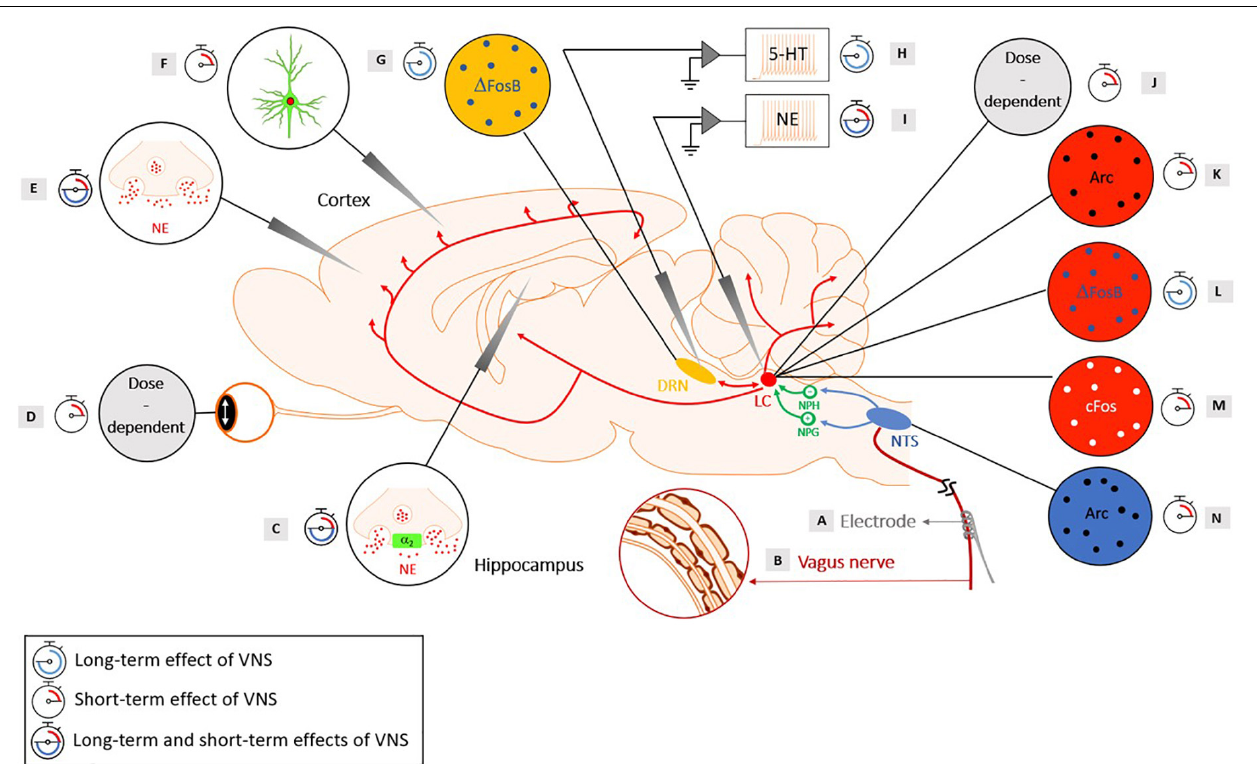
FIGURE 1 | Evidence of the activation of the noradrenergic system in rats with short-term and long-term cervical VNS, with the neuroanatomy of the brainstem nuclei involved in the mechanisms of action of VNS. Yellow: Dorsal Raphe Nucleus (DRN), red: Locus Coeruleus (LC), green: Nucleus Prepositus Hypoglossi (NPH), an inhibitory input to the LC and the Nucleus Paragigantocellularis (NPG), an excitatory input to the LC, blue: Nucleus Tractus Solitarius (NTS). (A) A helicoidal electrode is wrapped around the vagus nerve and stimulates the nerve. (B) The vagus nerve is composed of three types of fibers: (A) (large-diameter myelinated), (B) (small-diameter myelinated) and (C) (unmyelinated) fibers that have different electrical conductances. (C) An intensity-dependent increase in NE concentration following VNS was observed in the hippocampus of healthy rats for a range of intensities of 0.5–1 mA (20 Hz, 500 µ s pulse width, and 30 s duration) (Roosevelt et al., 2006). Another study observed an increased concentration of extracellular NE in the hippocampus following VNS administration (1 mA, 30 Hz, 250 µ s pulse width, 7 s ON, and 18 s OFF), with an increase of at least 70% preventing the development of pilocarpine-induced limbic seizures (Raedt et al., 2011). Blocking the α 2 -adrenoreceptor in the hippocampus of rats that were responders to VNS reversed the seizure-suppressing effects (Raedt et al., 2011). An increased activation of post-synaptic α 2 -adrenoreceptors located in a subfield of the Cornu Ammonis (CA3) of the hippocampus was observed after long-term VNS (2 weeks, 0.25 mA, 20 Hz, and 500 µ s pulse width) (Manta et al., 2013). A study showed that VNS (1 mA, 20 Hz, and 500 µ s pulse width) produced a persistent enhanced synaptic transmission between the perforant path and the CA3 region that was abolished when the LC was lesioned and when a β -adrenergic receptor antagonist was injected in the lateral ventricle (Shen et al., 2012). (D) During stimulation, a sigmoid-like relationship was found between the pupil dilation and the charge per pulse (Mridha et al., 2021). An increased pupil diameter was observed with an increasing current intensity and duration in a dose-dependent manner (Collins et al., 2021). (E) A significant increased NE was reached in the cortex following VNS with an intensity of 1 mA (20 Hz, 500 µ s pulse width, and 30 s duration) (Roosevelt et al., 2006). Another study observed an increased level of extracellular NE in the prefrontal cortex after long-term VNS (2 weeks, 0.25 mA, 20 Hz, and 500 µ s pulse width) (Manta et al., 2013). (F) A study using GCaMP6s imaging in Thy1-GCaMP6s mice revealed an increased fluorescence in NE axons within the dorsal cerebral cortex during VNS, with larger and longer lasting effects for higher intensities and longer pulse width stimulations (Collins et al., 2021). (G) An increase in (cid:49) FosB was observed in the DRN after chronic VNS (3 weeks), but no increase in c-Fos was observed after acute VNS (2 h) in the DRN (0.25 mA, 20 Hz, 250 µ s pulse width, 30 s ON, and 5 min OFF) (Cunningham et al., 2008). (H) An increased basal firing rate of the serotonergic neurons in the DRN was observed after long-term (14-, 21-, and 90-day) VNS treatments, but not after short-term (1-h, 1-day, and 3-day) VNS treatments (0.25 mA, 20 Hz, 500 µ s pulse width, 30 s ON, and 5 min OFF) (Dorr and Debonnel, 2006). Another study showed an increased basal firing rate of the serotonergic neurons in the DRN after 14 days, but the increase was abolished when the LC was lesioned (0.25 mA, 20 Hz, 500 µ s pulse width, 30 s ON, and 5 min OFF) (Manta et al., 2009). (I) An increased discharge rate of the LC was observed with acute VNS (0.3 mA, 20 Hz, and 500 µ s pulse width) (Groves et al., 2005). An increased firing rate of the LC was found after short-term (1-h, 1-day, and 3-day) and long-term (14-, 21-, and 90-day) VNS treatments (0.25 mA, 20 Hz, 500 µ s pulse width, 30 s ON, and 5 min OFF) (Dorr and Debonnel, 2006). An increased percentage of NE neurons displaying bursts and an increased number of bursts per minutes were observed in VNS-implanted rats after 14 days of VNS compared to control rats and the number of spikes per burst was even further increased after 90 days of VNS (0.25 mA, 20 Hz, 500 µ s pulse width, 30 s ON, and 5 min OFF) (Manta et al., 2009). (J) A study showed that increasing the current intensity resulted in a shorter latency to the onset of a significant driven activity of the LC. Moreover, a monotonical increase of the neural activity in the LC was observed with increasing the current intensity as well as increasing the pulse width. Finally, higher-frequency stimulation yielded to a strong but transient activation of the LC, while lower-frequency trains lead to a smaller but longer activation of the LC (Hulsey et al., 2017). (K) The presence of the Arc protein was found in the LC after 10 min of VNS (1 mA, 20 Hz, 500 µ s pulse width) (Shen et al., 2012). (L) A study observed (cid:49) FosB in the LC after chronic VNS (3 weeks) (0.25 mA, 20 Hz, 250 µ s pulse width, 30 s ON, and 5 min OFF) (Cunningham et al., 2008). (M) A regional